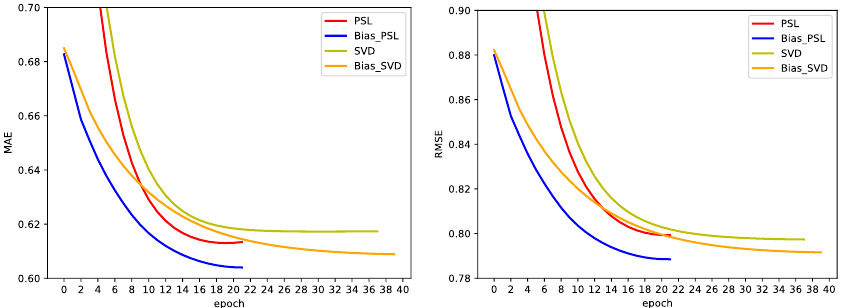
Figure 6. Training process of compared models on MovieLen-10 M with 50 latent factors.